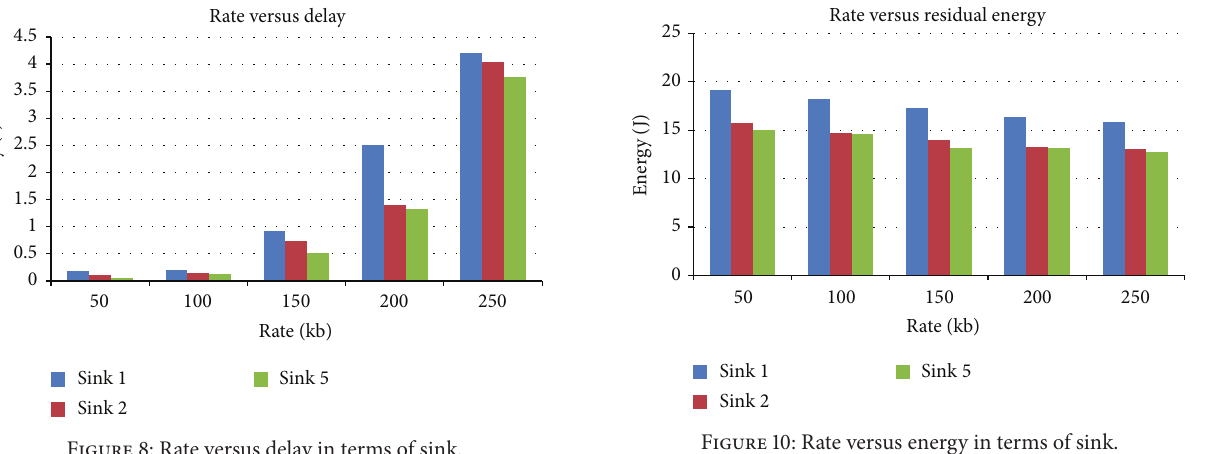
Figure 8: Rate versus delay in terms of sink.